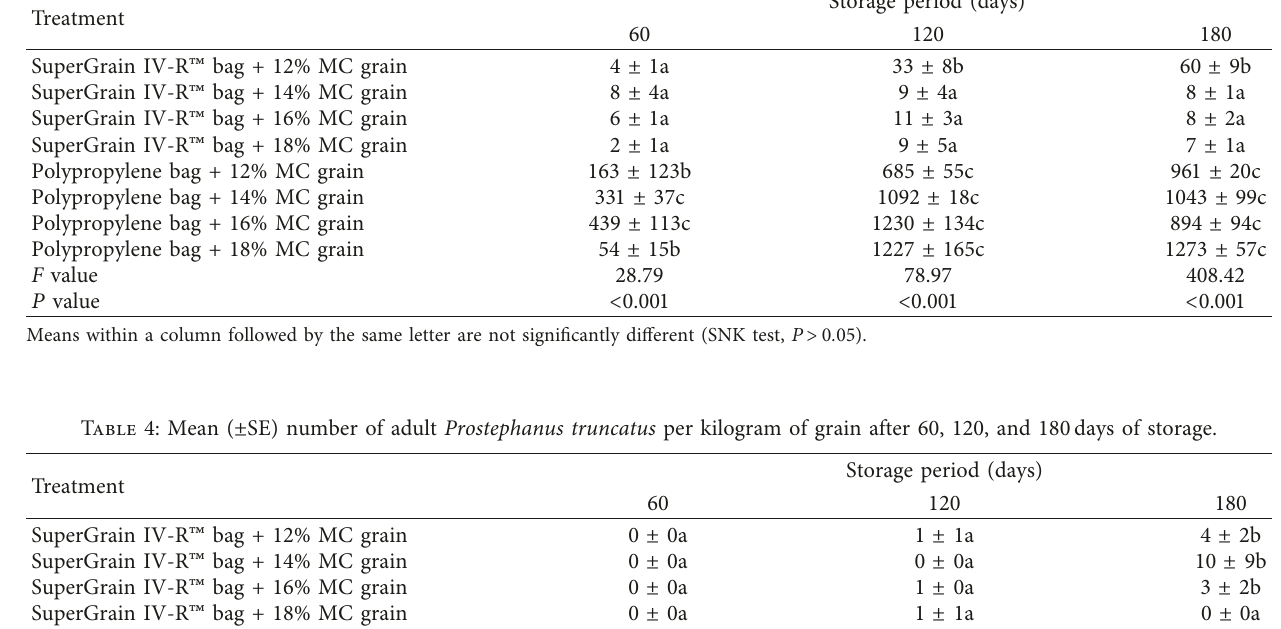
Table 3: Mean ( ± SE) number of adult Sitophilus zeamais per kilogram of grain after 60, 120, and 180 days of storage.